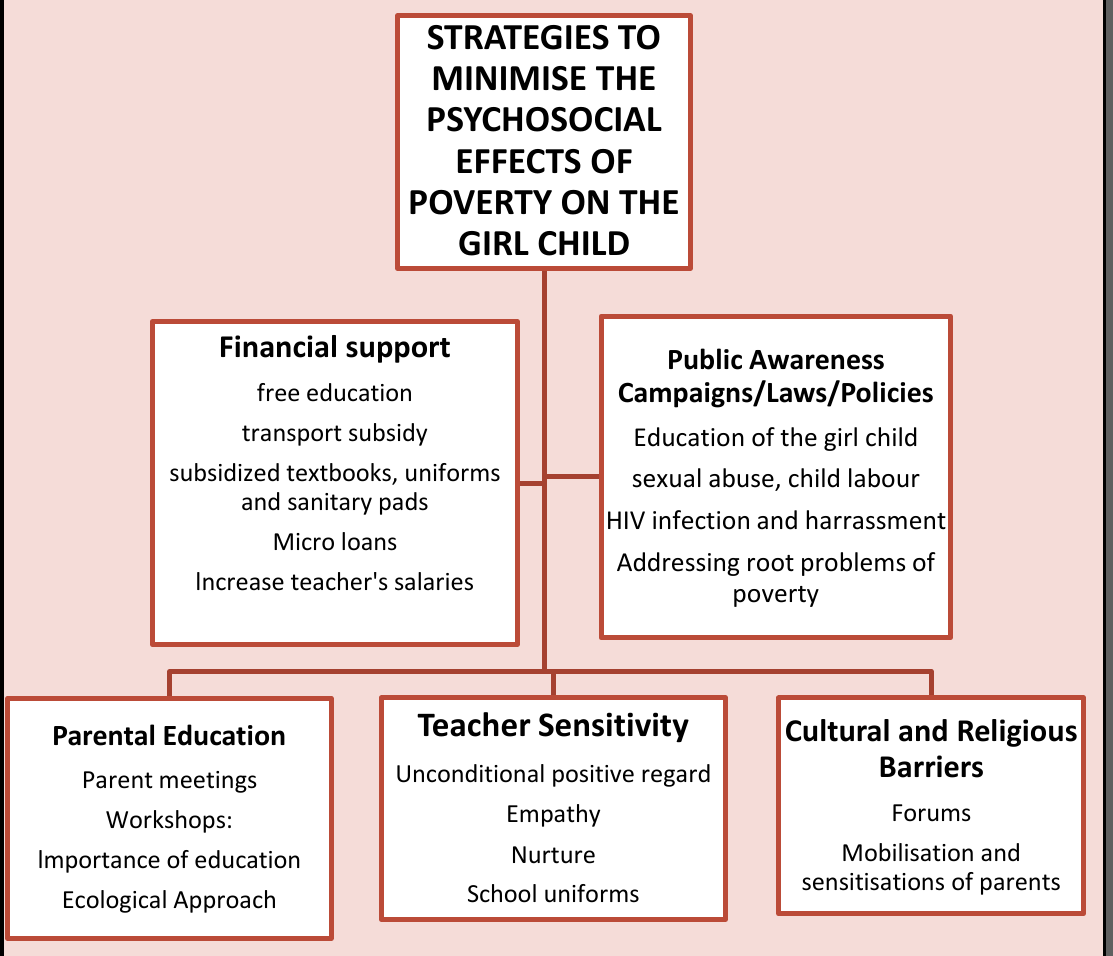
Figure 6.1: Summarising strategies to minimise effects of poverty on girl learners 6.4.1 Recommendations from this study as derived from fig